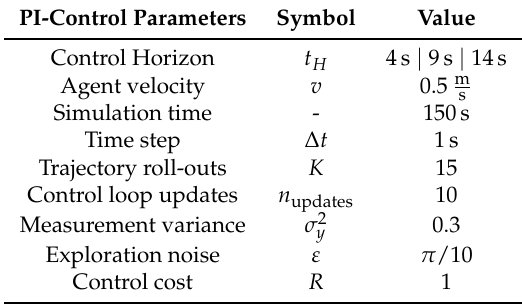
Table 3. PI-STKF simulation